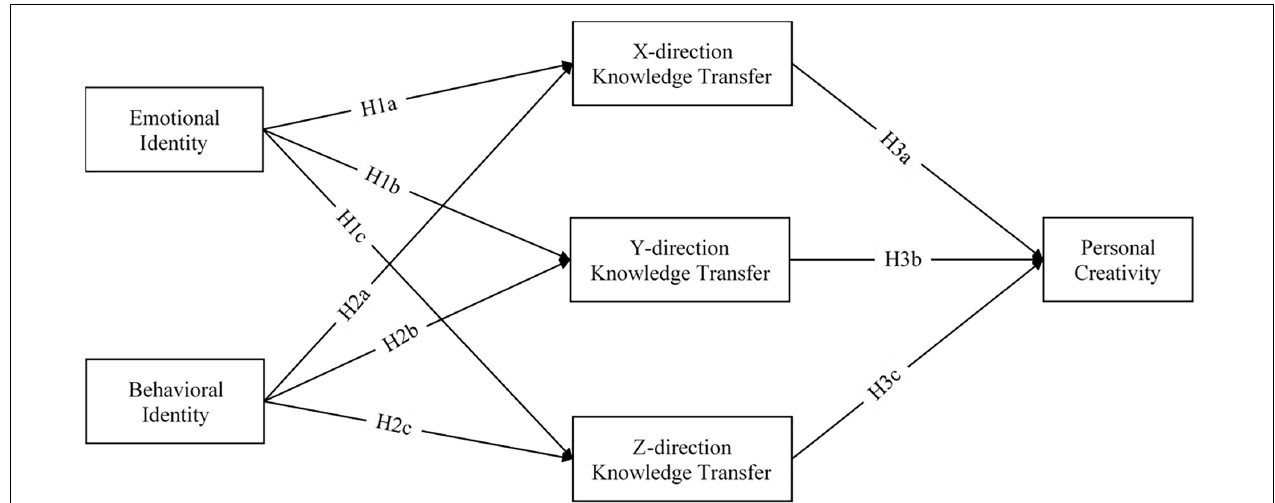
FIGURE 1 | Proposed research